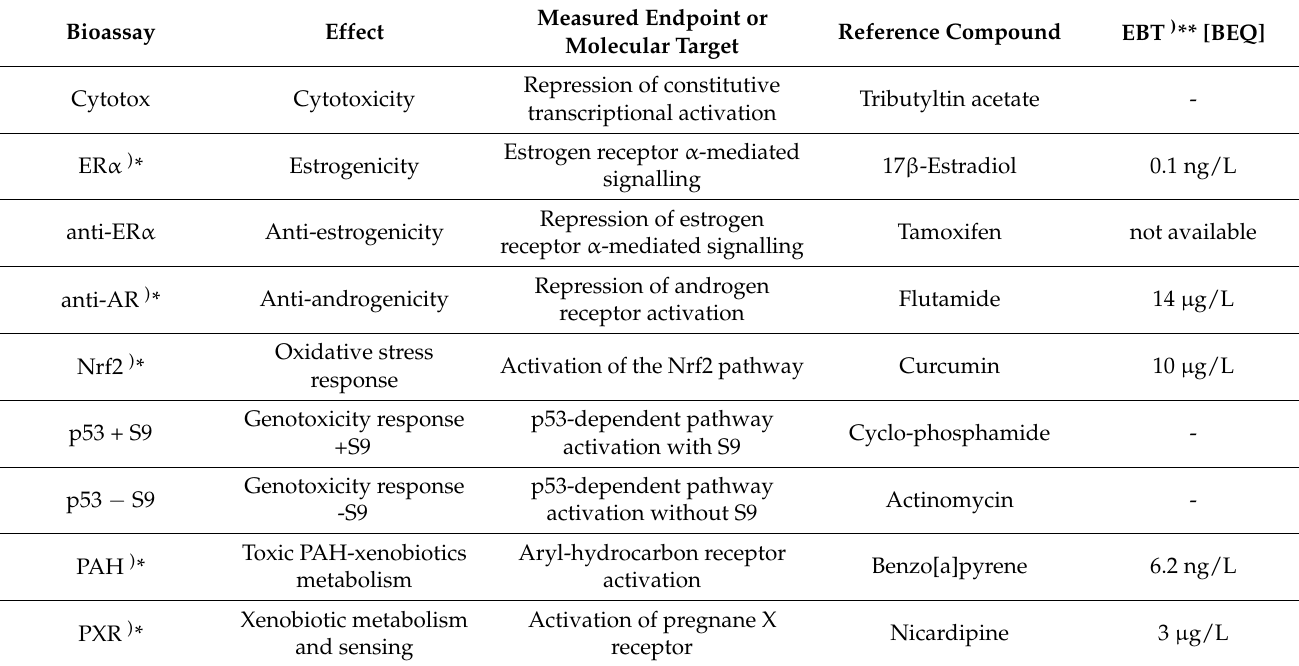
Table 1. Information on the CALUX in vitro bioassay panel and frequency of